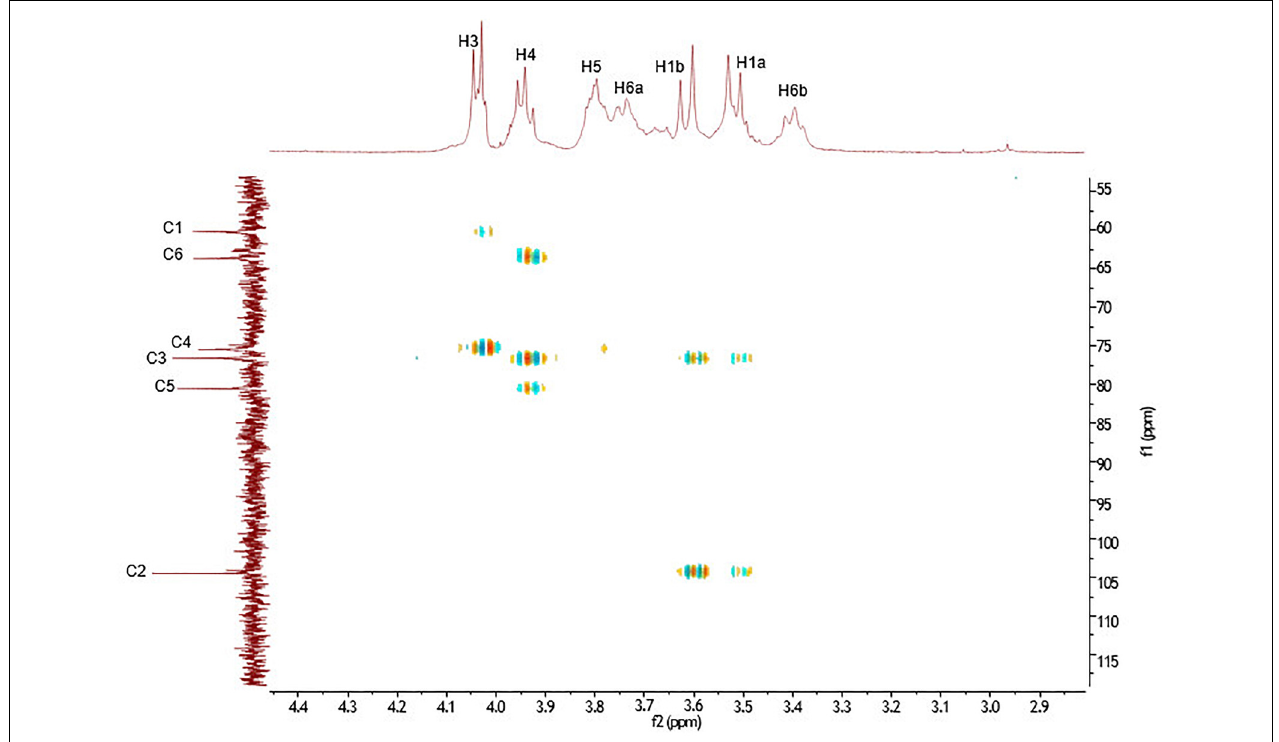
FIGURE 3 | HMBC spectrum in D 2 O showing the correlations ( 2 J H / C and 3 J H / C ) between the 1 H and 13 C of the fructosyl residue of levan-type fructan polysaccharides from G. marginata stored in the underground system.